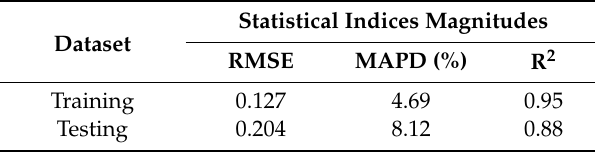
Table 5. Statistical indices for training and testing datasets.